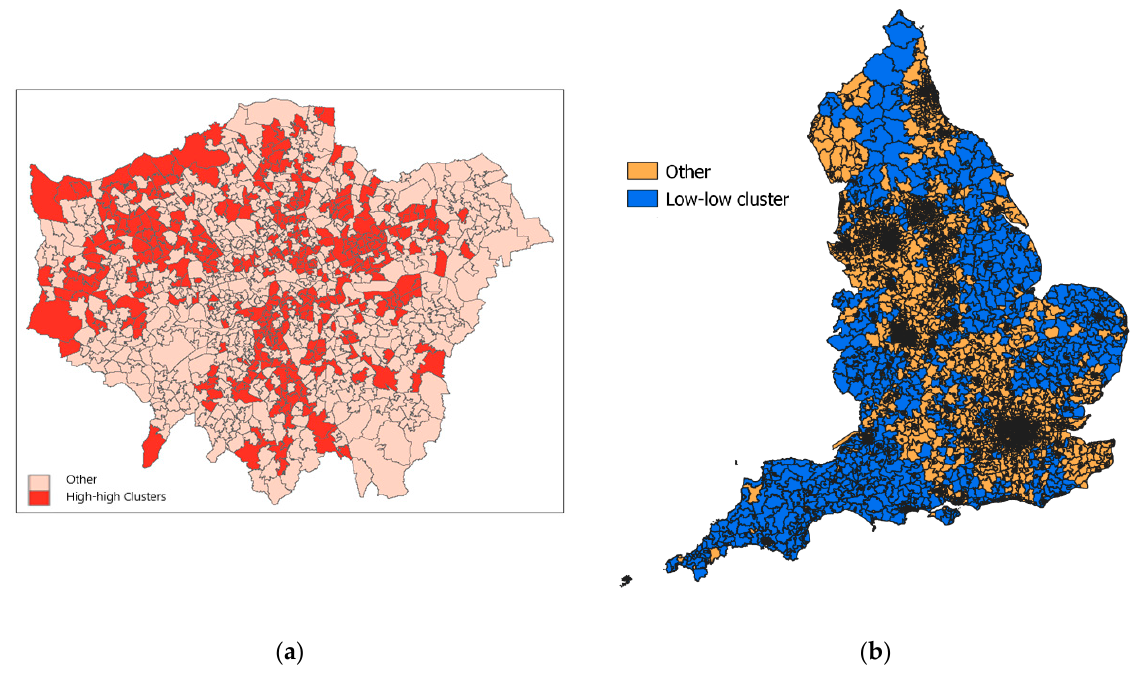
Figure 1. ( a ) High-mortality clusters in Londonl; ( b ) Low-mortality clusters across